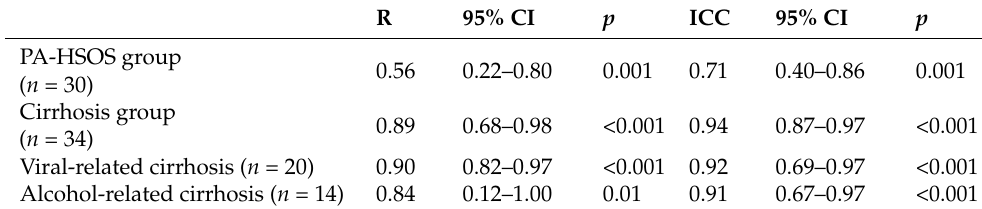
Table 4. Correlation between FHVP and IVCP.